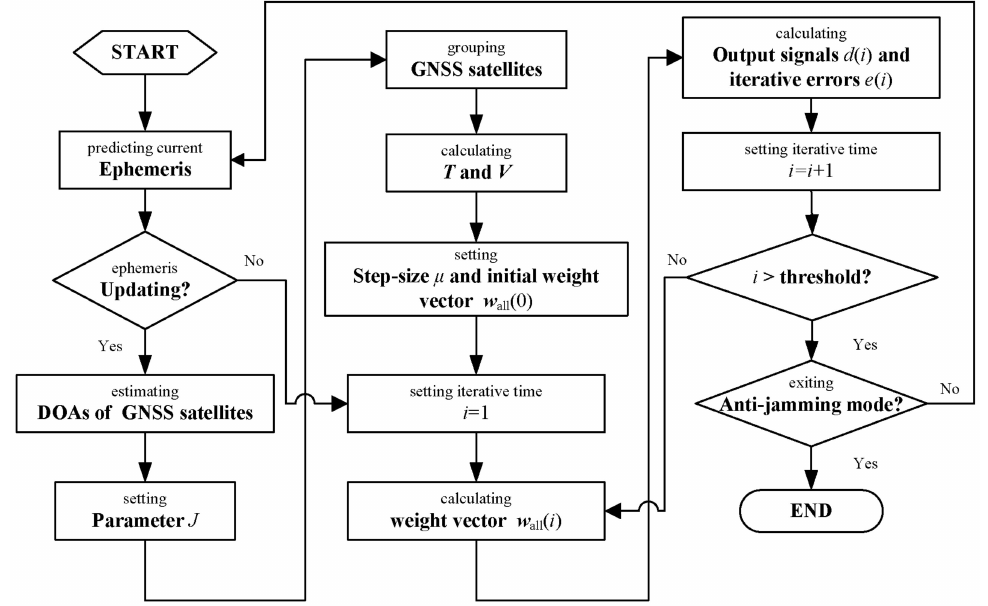
Figure 3. Flow chart of the proposed